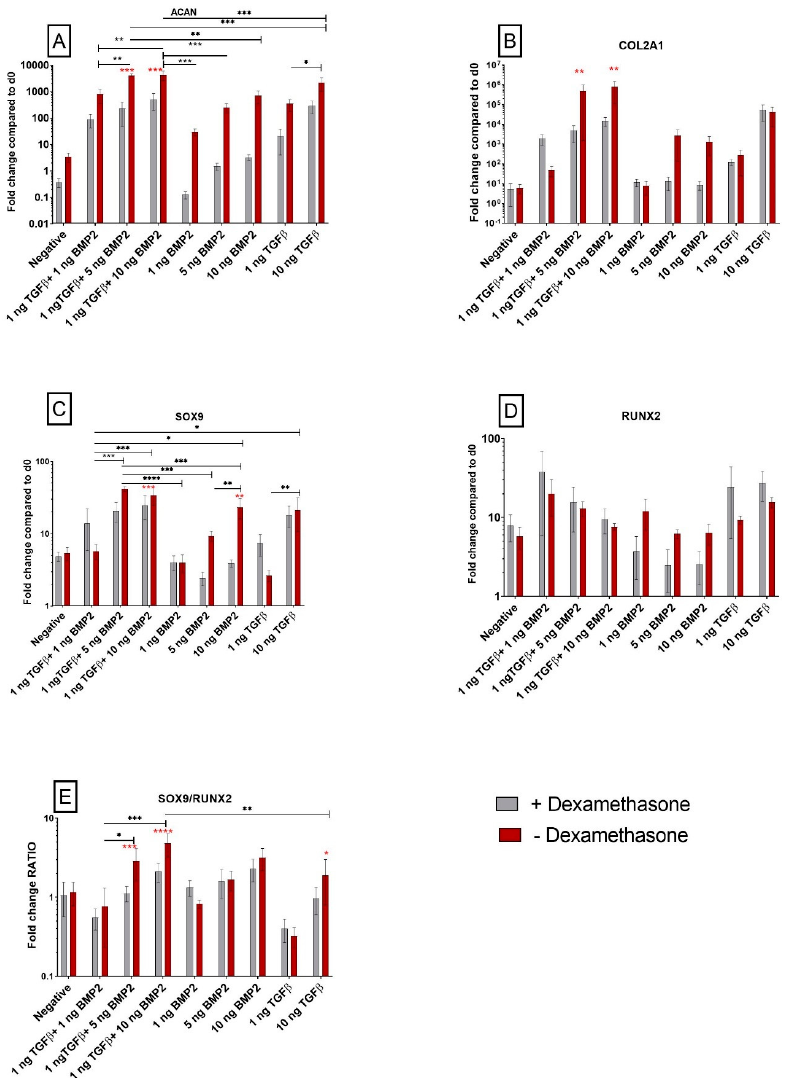
Figure 1. E ff ect of TGF- β 1 and BMP-2 on the expression of genes orchestrating human synovial-derived stromal cell (hSDSC) chondrogenic commitment. Cells were induced to chondrogenic di ff erentiation for 21 days in the presence (positive control) or absence (negative) of 10 ng/mL TGF- β 1. Experimental groups contained low TGF- β 1 concentrations (1 ng / mL TGF- β 1), various concentrations of BMP-2 alone (1 ng / mL BMP-2, 5 ng / mL BMP-2, 10 ng / mL BMP-2), or BMP-2 in combination with 1 ng / mL TGF- β 1 (1 ng / mL TGF- β 1 + 1 ng / mL BMP-2, 1 ng / mL TGF- β 1 + 5 ng / mL BMP-2 and 1 ng / mL TGF- β 1 + 10 ng / mL BMP-2). The amounts of ACAN ( A ), COL2A1 ( B ), SOX9 ( C ), RUNX2 ( D ) mRNA were normalized to 60S acidic ribosomal protein P0 ( RPLP0 ) and SOX9 / RUNX2 ratio ( E ) was calculated as the ratio between the fold change of each gene. The levels of gene expression of cells exposed to di ff erent media in the presence or absence of 100 nM dexamethasone were plotted as a fold change relative to the expression of the corresponding gene in undi ff erentiated cells (hSDSC day 0) defined as 1 (mean ± standard deviation (SD); n = 4). All data from 10 ng / mL TGF- β 1 (positive control), low TGF- β 1 concentration (1 ng / mL TGF- β 1), and 1 ng / mL TGF- β 1 combination with BMP-2 (1 ng / mL TGF- β 1 + 1 ng / mL BMP-2, 1 ng / mL TGF- β 1 + 5 ng / mL BMP-2 and 1 ng / mL TGF- β 1 + 10 ng / mL BMP-2) were significantly di ff erent from negative control. Grey bars represent scatterplot of di ff erent measurements in hSDSC exposed to dexamethasone; red bars represent scatterplot of di ff erent measurements in hSDSC not exposed to dexamethasone. Data are expressed as mean ± SD, significant di ff erences from dexamethasone treatment in the same group are marked by red asterisks; significant di ff erences among group are marked by black asterisks (* p ≤ 0.05, ** p ≤ 0.01, *** p ≤ 0.001, **** p ≤